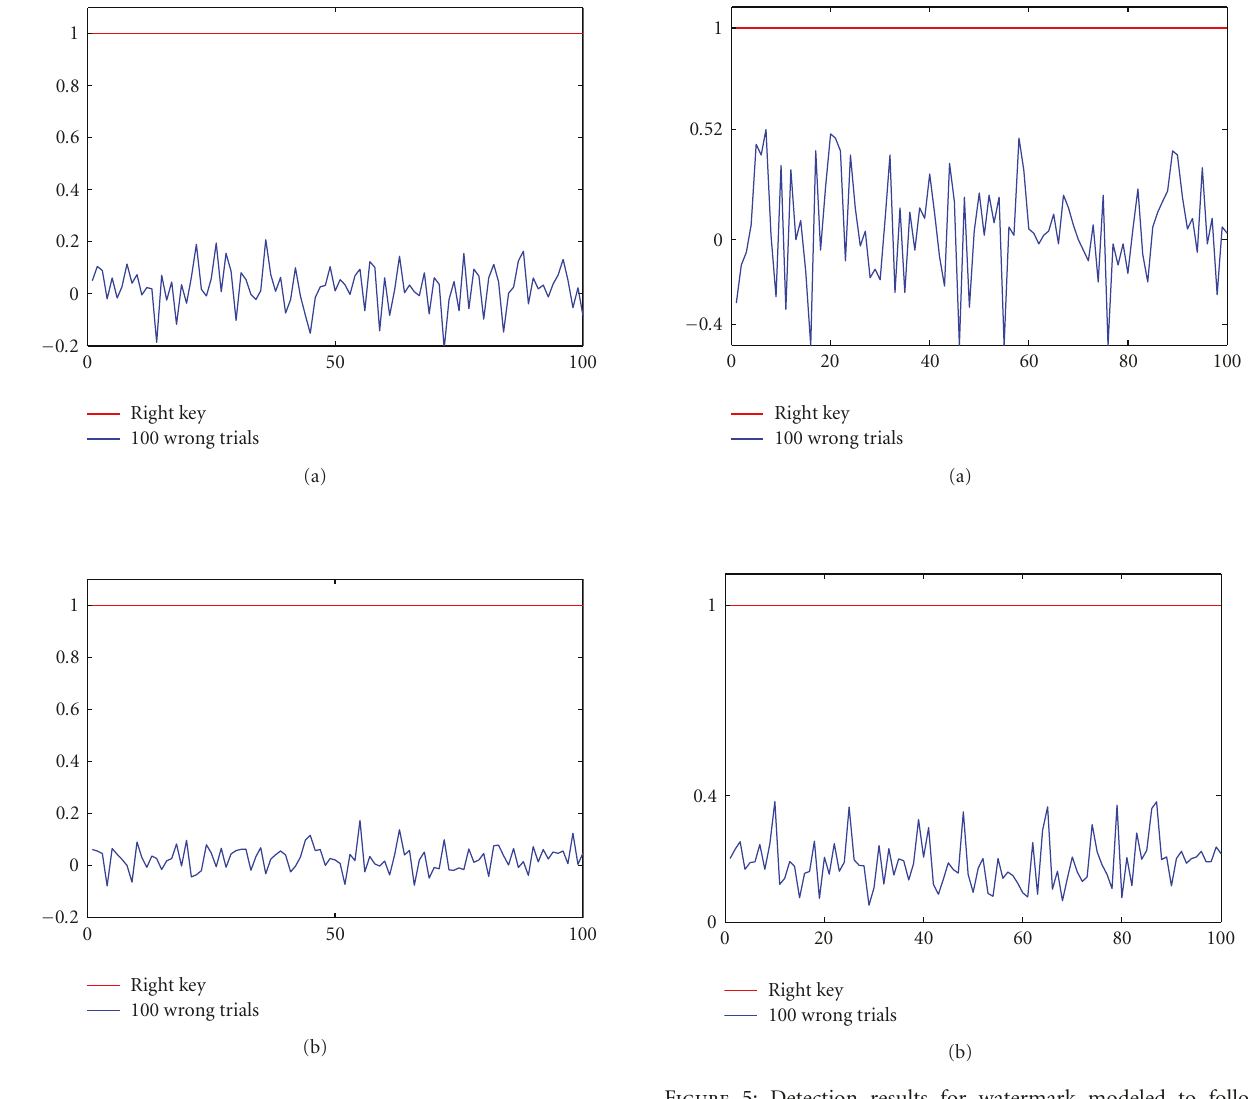
pitch scaling, echo, amplitudes normalization, and so